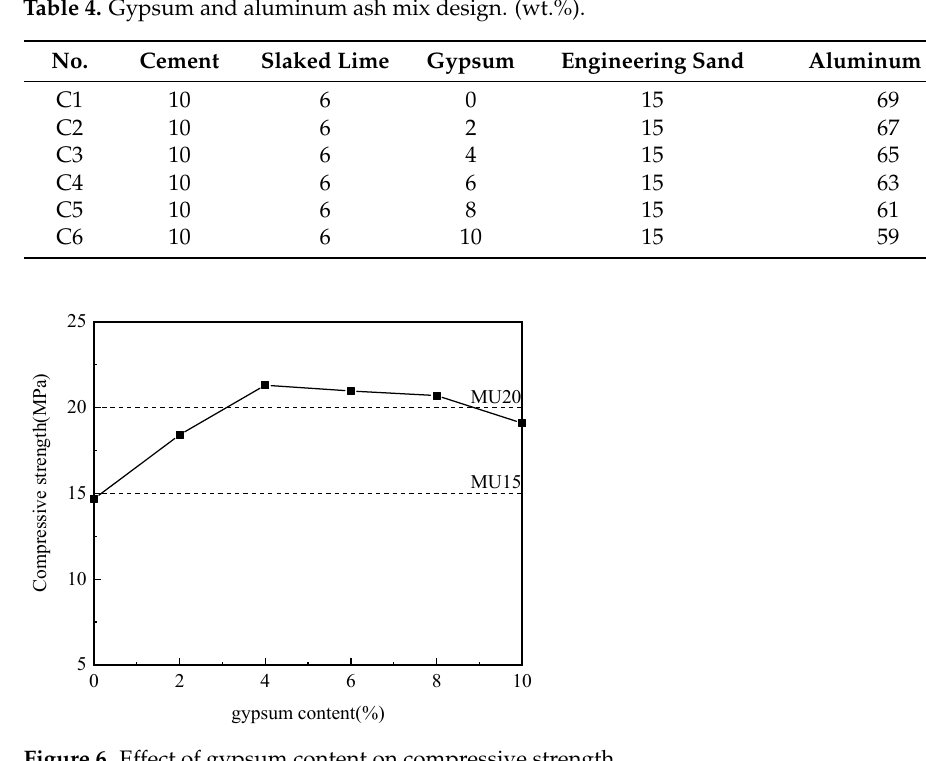
Figure 6. Effect of gypsum content on compressive strength.